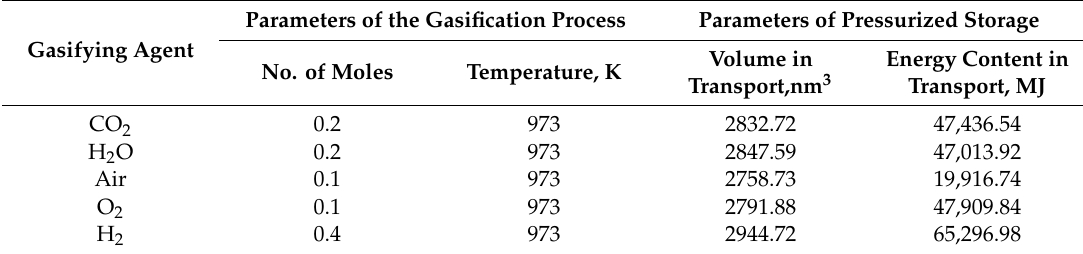
Table6. Presentationofresultsofthestudy. Energycontentinthetransportforgivenprocessparameters.